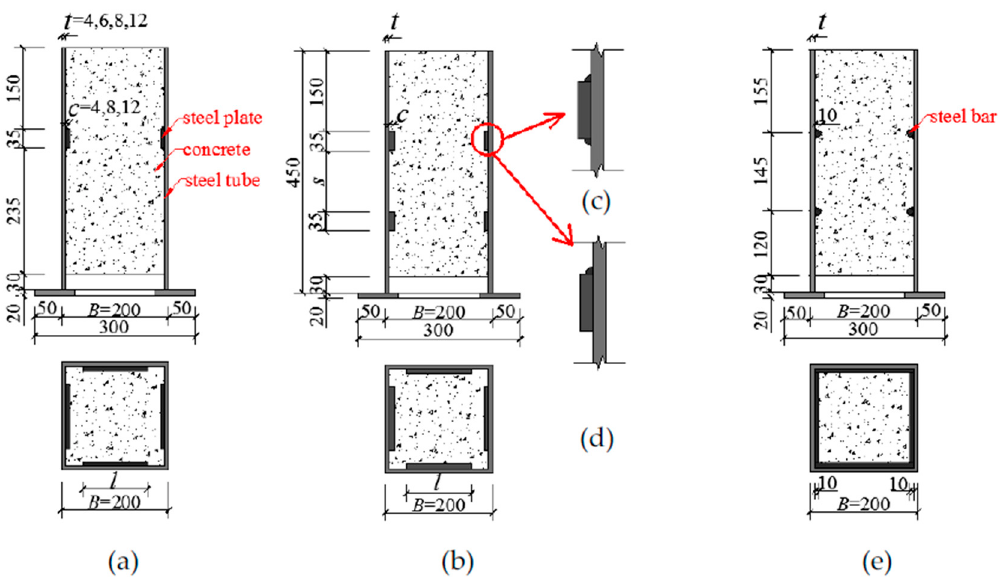
Figure 4. Details and dimensions of specimens. ( a ) Single-layer; ( b ) Double-layer; ( c ) Double-sided welding; ( d ) Single-sided welding; ( e ) Steel bar.